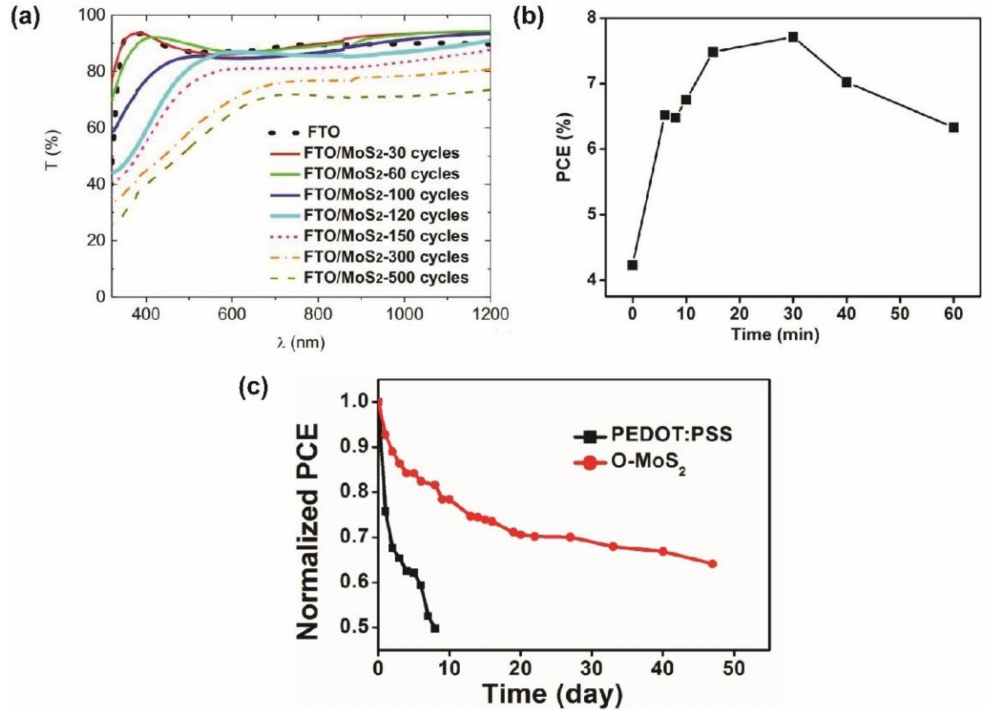
Figure 8. ( a ) Transmission spectra of FTO/MoS 2 at various numbers of scan cycles. Adapted with permission from [199]. Copyright 2017, Elsevier. ( b ) Dependence of PCE on the duration of the UVO treatment and ( c ) stability of devices using UVO-MoS 2 QDs compared with PEDOT:PSS. Adapted with permission from [200]. Copyright 2016, American Chemical